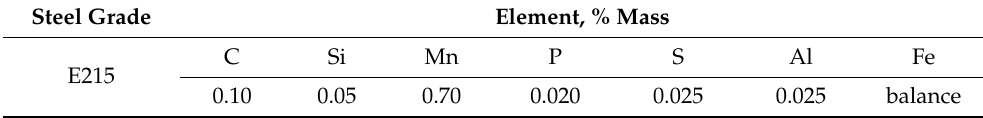
Table 1. Chemical composition of E215 low-carbon steel used for rivets manufacturing. Steel